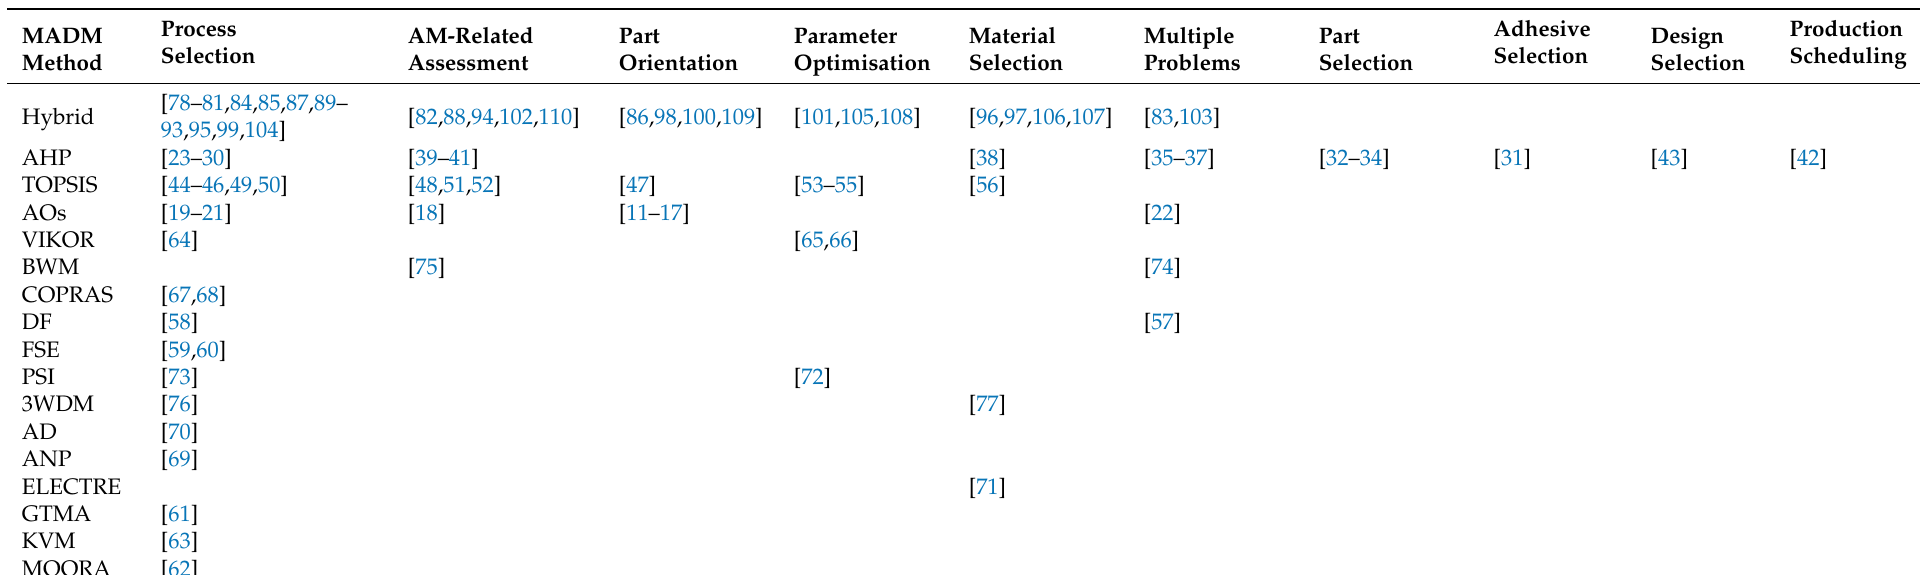
Table 3. Distribution of the articles with respect to the applied MADM methods and the solved